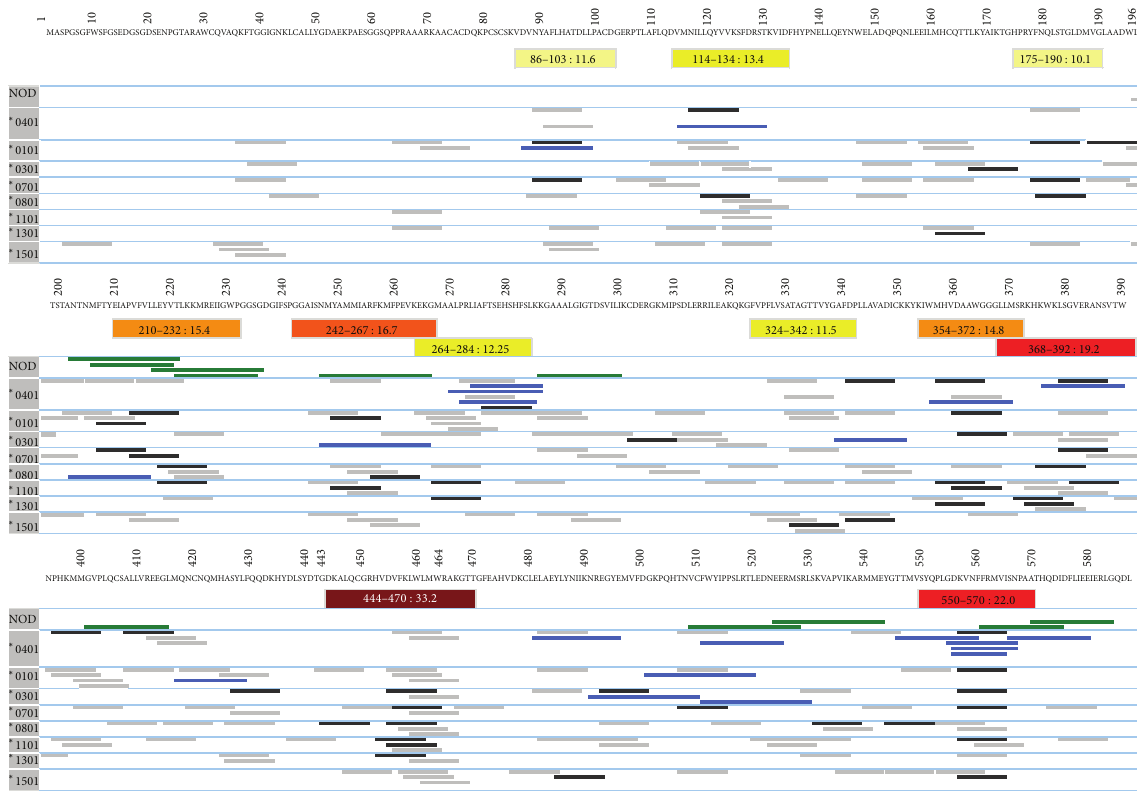
Figure 2: Map of GAD65 epitopes performed using EpiMatrix. EpiMatrix-predicted epitopes are shown in shades of grey and black; darker colors denote stronger binding potential. Published human epitopes are in bright blue. Clusters are identified in shades of yellow-orange- red; again, stronger colors (more red) denote higher predicted immunogenicity. Previously published NOD epitopes are shown in green. The clustering of predicted (and published) epitopes is clearly illustrated for EpiMatrix-predicted epitope clusters 450–470 (shown in greater detail in Figure 3(a)) and 550–570 (Figure